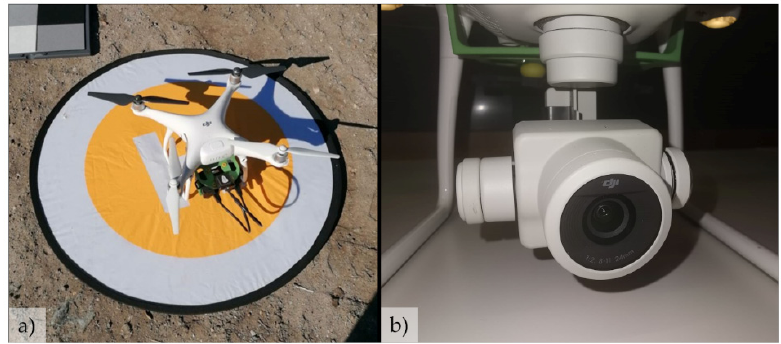
Figure 3. UAV system: DJI Phantom 4 Pro ( a ) and sensor ( b ). The UAV was equipped with an optical sensor FC6310 (Figure 3b) for RGB data collection, which has a nominal focal length (f) of 8.8 mm and a physical size of 13.2 mm by 8.8 mm. This sensor has a resolution of 20 MPixel (5472 × 3648 pixels) and a pixel size of 2.41 mm. Assuming the characteristics of sensor and flight heights between 100 m and 350 m, the ground sampling distance (GSD) varies from approximately 3 to 10 cm, respectively. The GSD is given by the following equation [37]: